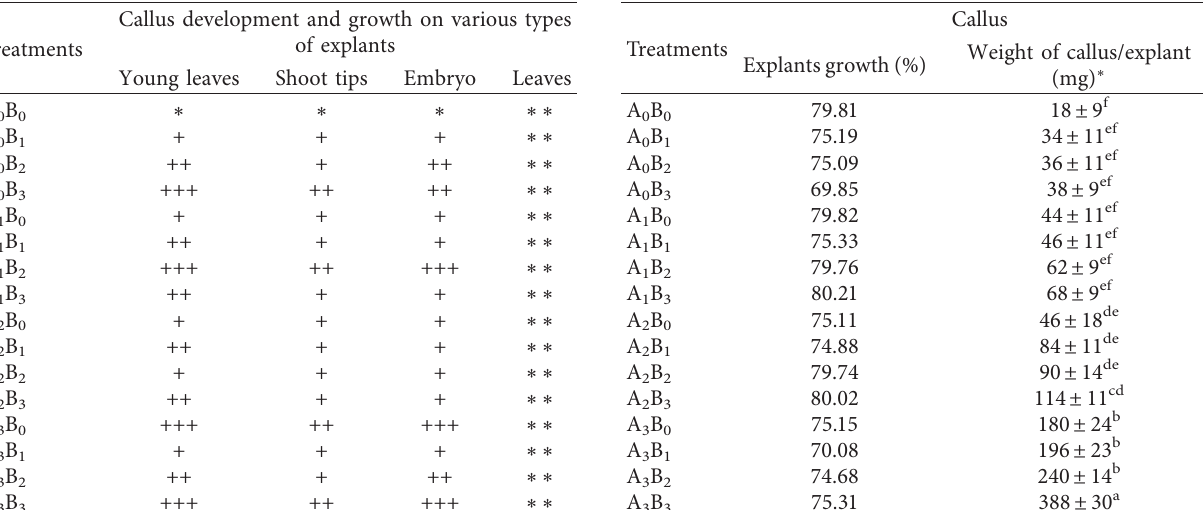
Figure 1: Micropropagation of Sumatra Benzoin by callus subculture from young leaf explants. (a) Seven-week-old callus. (b) Callus subculture in the media. (c) Regeneration into shoots. (d) Planlets (arrow showing root growth) after incubation for 12 weeks. Table 3: Development of callus of Styrax benzoin Dryander after Table 4: Growth and development of callus of Styrax benzoin seven weeks of culture (treatments are specified in Table 2). Dryander from young leaves after seven weeks of